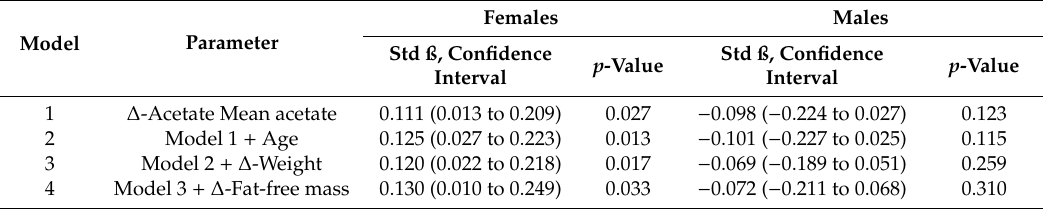
Table 2. Determinants of changes in HOMA-IR in participants during weight loss.